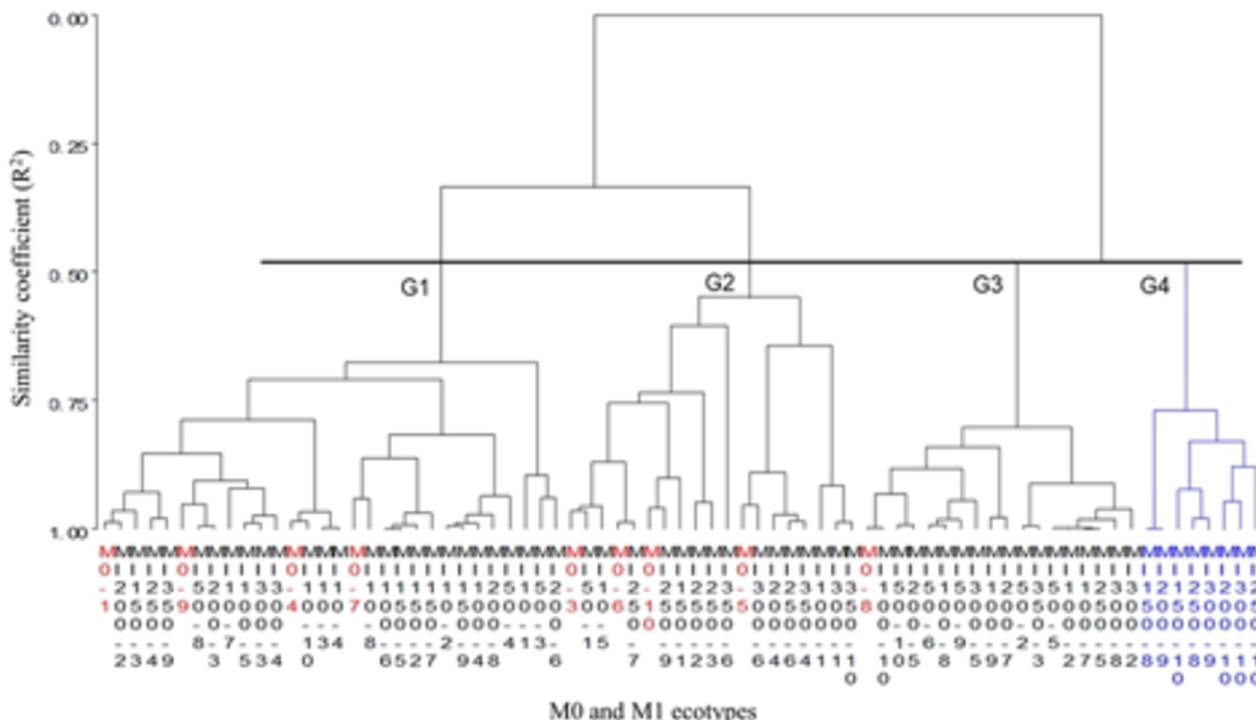
Fig 1. Hierarchical Cluster Analysis with Ward’s linkage, based on 18 morphological variables of 75 genotypes of natal grass [ Melinis repens (Willd.) Zizka], germinated from seed exposed to different doses of radiation with Co 60 (M1) and from non-irradiated seed (M0).